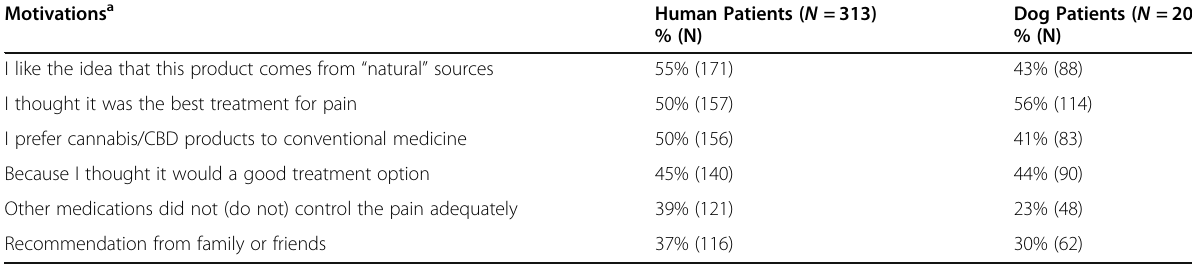
Table 3 Most Common Motivations for Using Cannabis Products to Treat Chronic Pain for Human Patients and Dog Patients Motivations